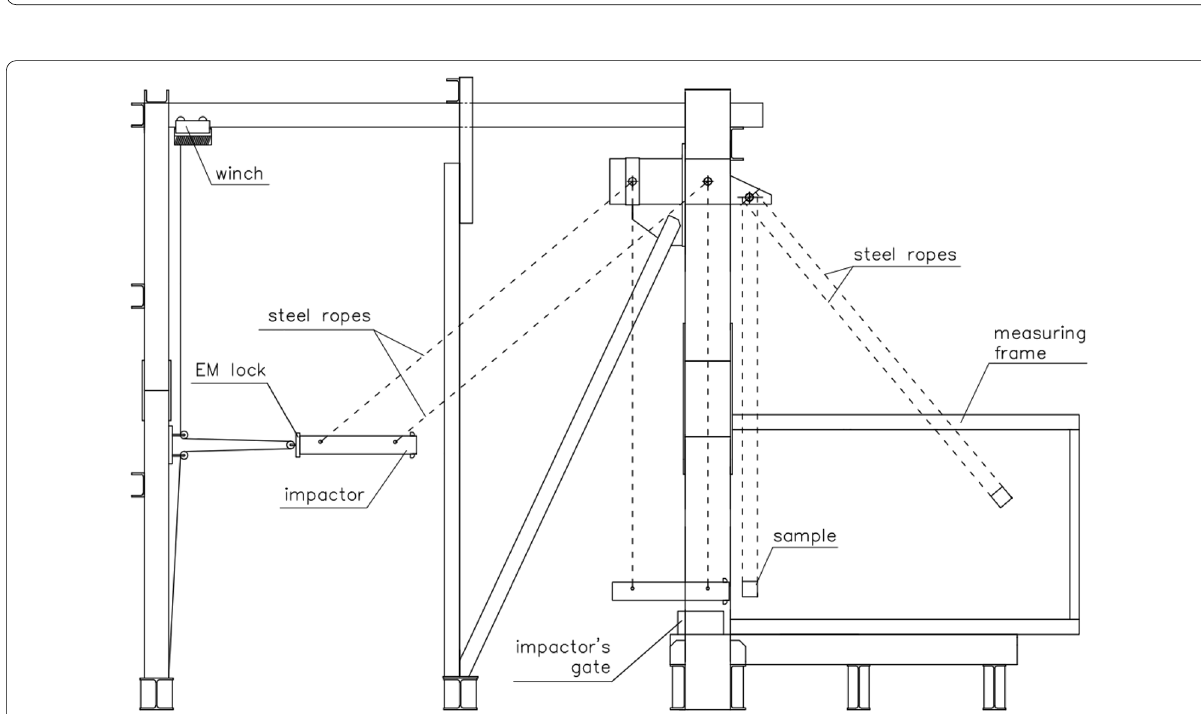
Fig. 2 The schematic of the impact